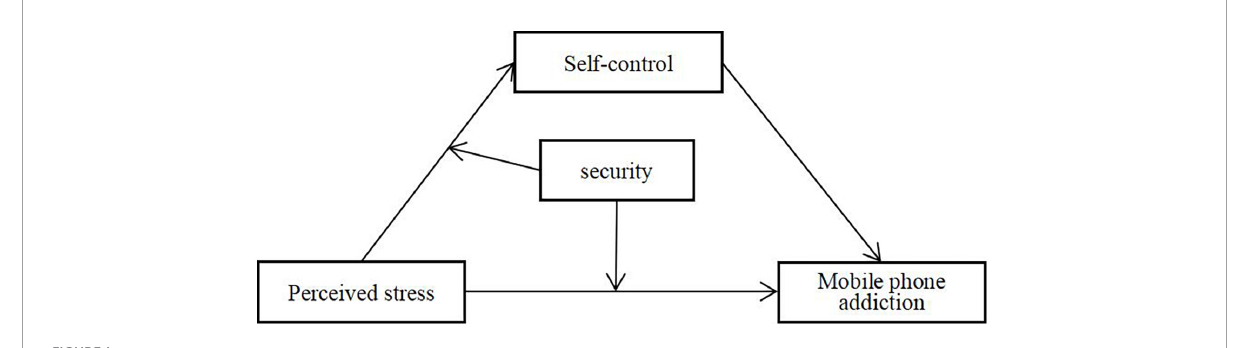
FIGURE1 The moderated mediation